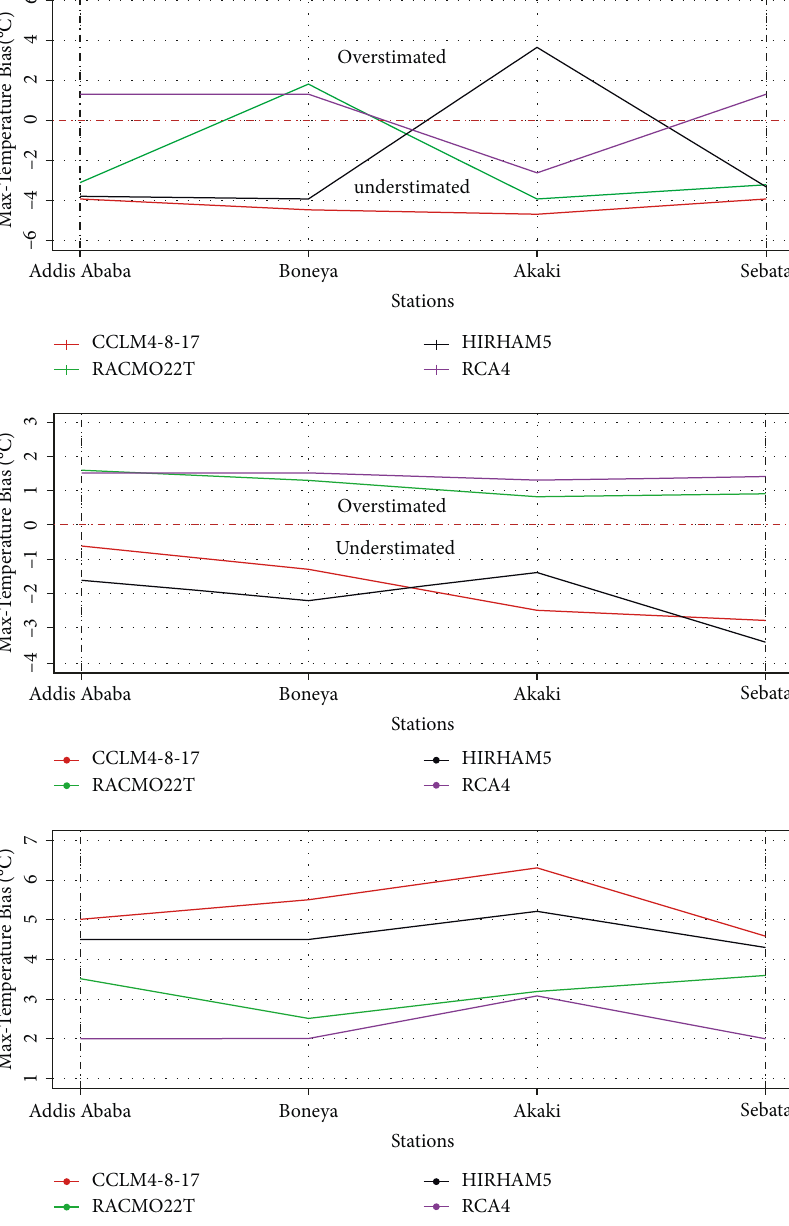
Figure 10: RMSE and BIAS of mean annual minimum and maximum temperature between simulated and observed at Akaki